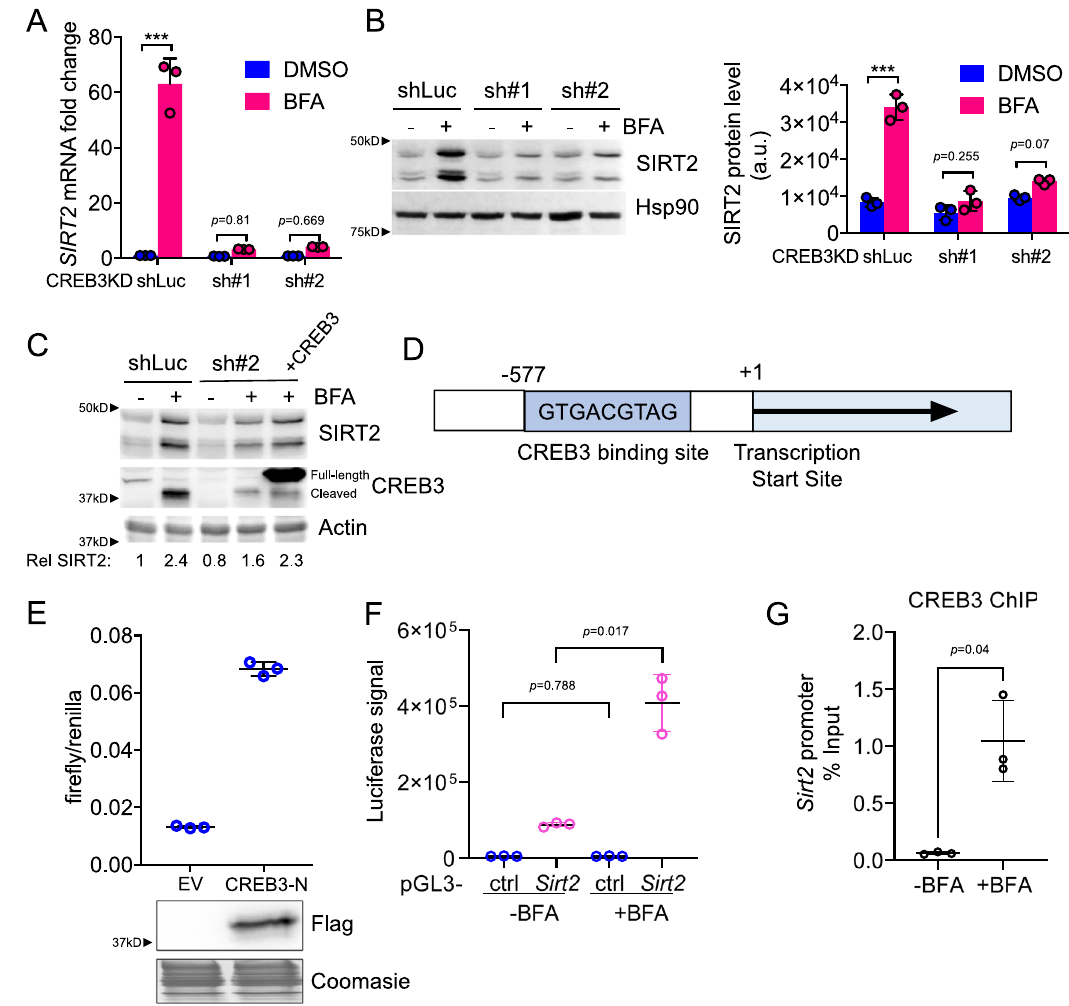
Fig. 2 | CREB3 promotes SIRT2 transcription under Golgi stress. A RT-PCR analysisfor Sirt2 mRNAinA549CREB3KDcellstreatedwithorwithoutBFA.mRNA isnormalizedtoDMSOtreatedcontrol(shLuc)cells.Statisticalevaluationwasdone by two-way ANOVA. B Immunoblots for SIRT2 protein levels in A549 control (shLuc)andCREB3KDcellstreatedwithorwithoutBFA.HSP90blotwasusedasthe loading control.The quanti fi cation of SIRT2 protein level, normalized to HSP90,is shown on the right. Statistical evaluation was done by two-way ANOVA. C Immunoblots for SIRT2 in control and CREB3 KD cells treated with BFA and rescued with CREB3 transfection. SIRT2 level relative to actin loading indicated below. D AschematicrepresentationofSIRT2promoter.Theannotatedregionsare